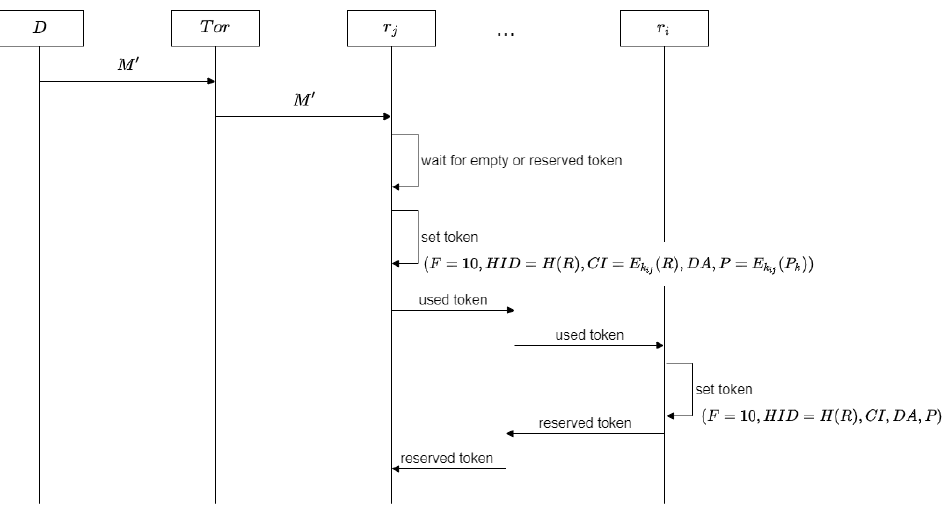
Figure 5. Transmission of the response M (cid:48)